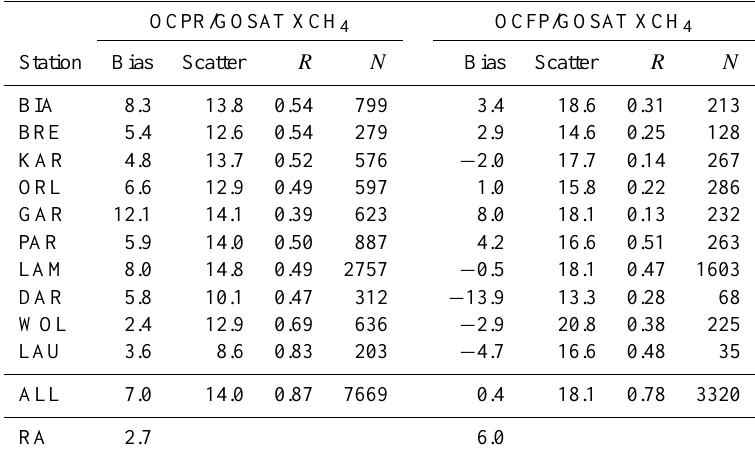
Table 9. OCPR and OCFP XCH 4 validation results for all individual stations and using all data combined (ALL). All results apart from R and N are in ppb